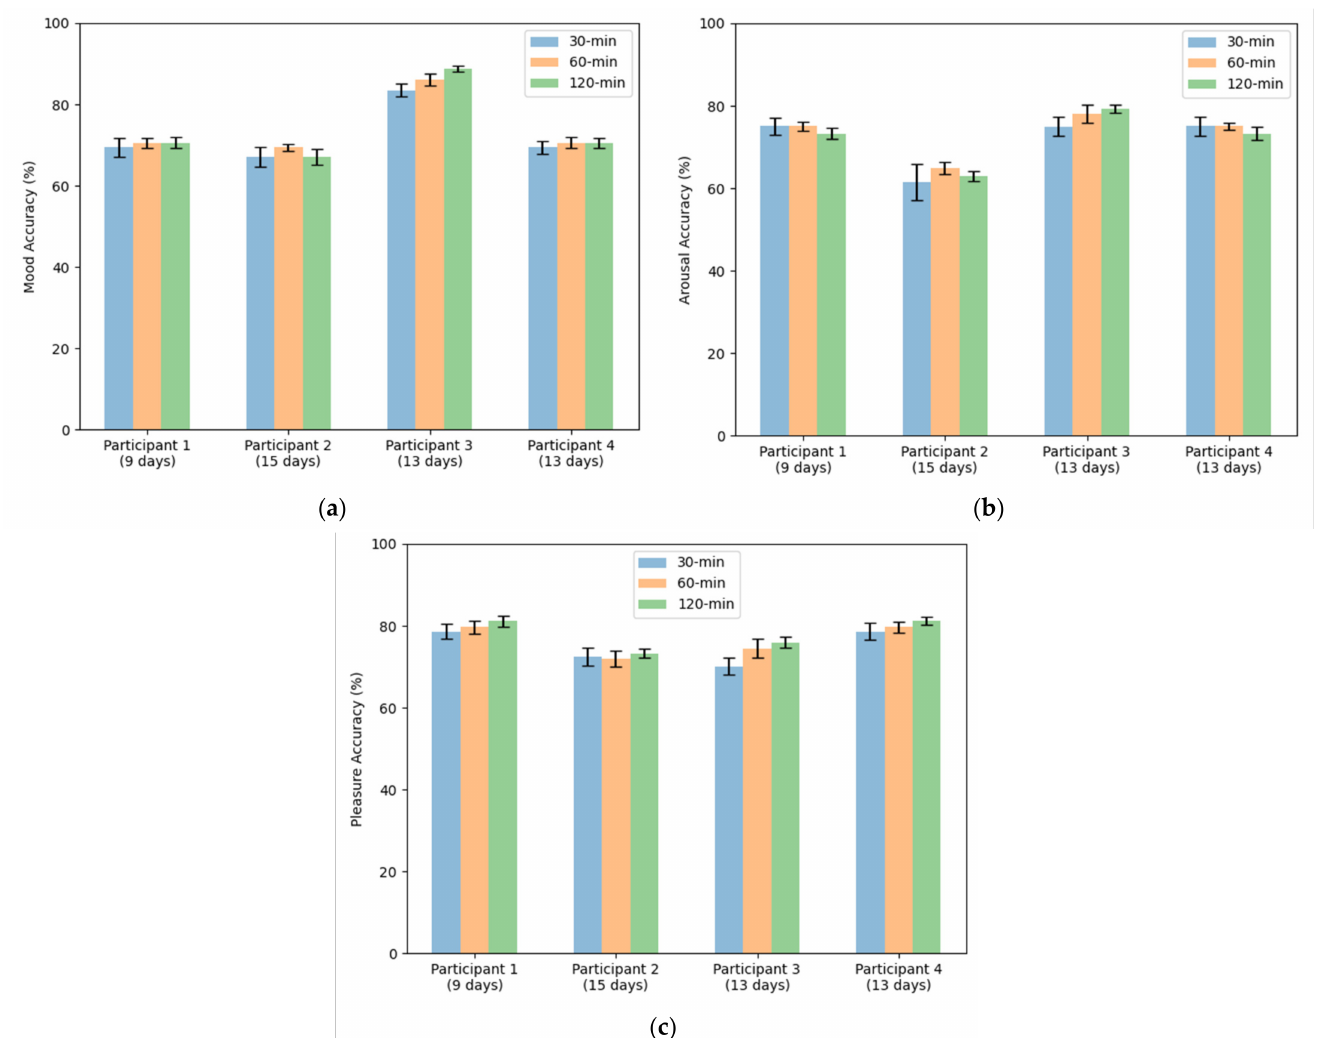
Figure 11. Accuracy metric obtained from predicting mood ( a ), arousal (or activeness) ( b ), and pleasure (or happiness) ( c ) values. Error bars represent standard deviation.